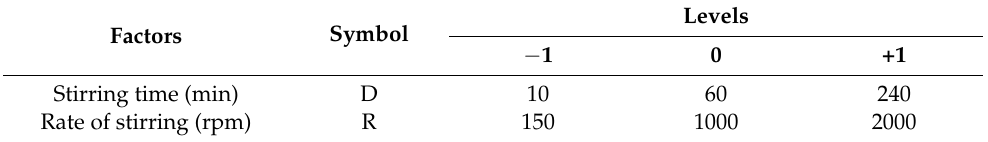
heterogeneity during the course of the experiment. The selected independent variables were stirring rate (R) and stirring duration (D). The experimental design in the actual levels is shown in Table 3. As for PBD, variations in retention rate between each couple dendrimers-EOs were recorded. In RSM experimental results (Table 4), negative percentage of retention notifies an increase in EOs volatility in presence of dendrimers. Maximums were represented with contour plots. Table 3. Factors and their levels selected for the Box–Behnken design (response surface methodology). Levels Factors Symbol